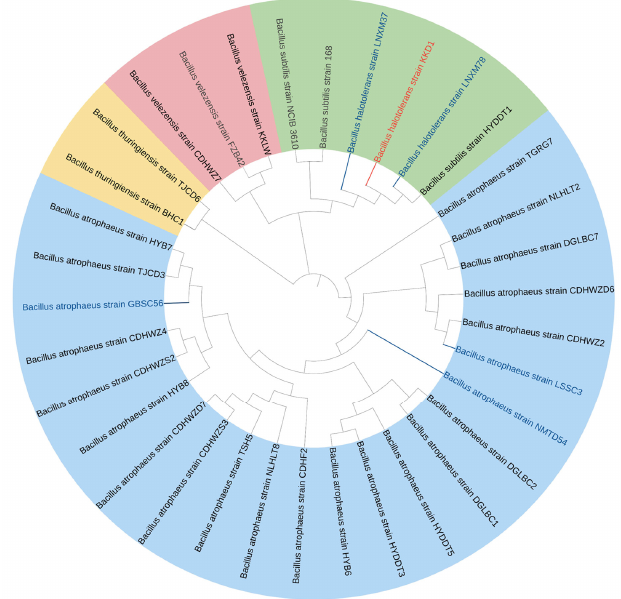
Figure 1. Phylogenetic tree based on the alignment of partial gyrB nucleotide sequences. The strains were clustered into four different groups: B. atrophaeus , B. velezensis , B. halotolerans , and B. thuringiensis . B. halotolerans KKD1 is labelled by red letters, and the model strains are labelled by grey letters. Strains previously isolated from the Qinghai–Tibetan Plateau are labelled by blue letters [3].